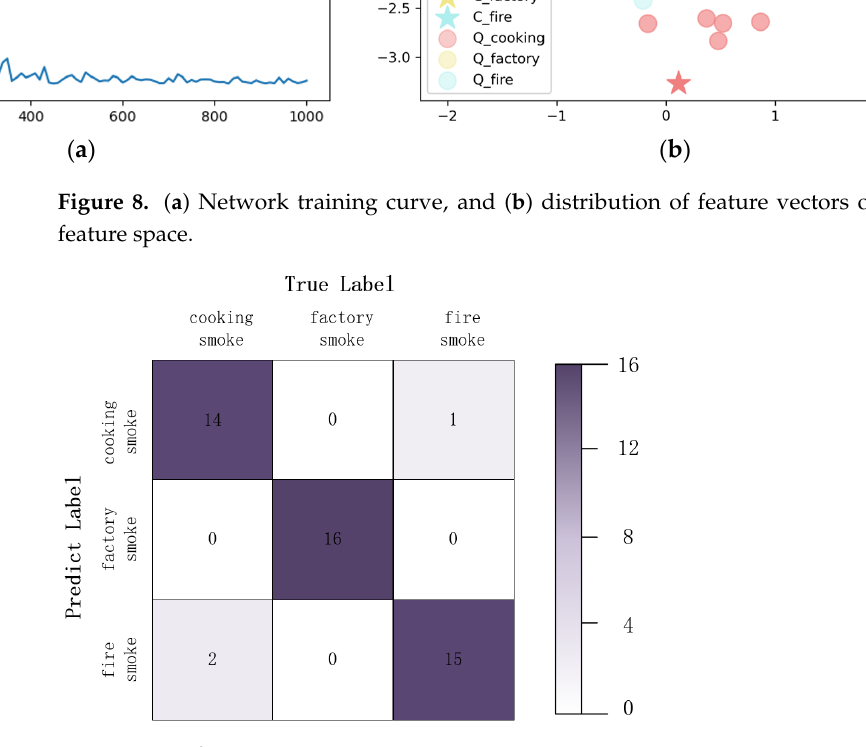
Figure 9. Confusion matrix.